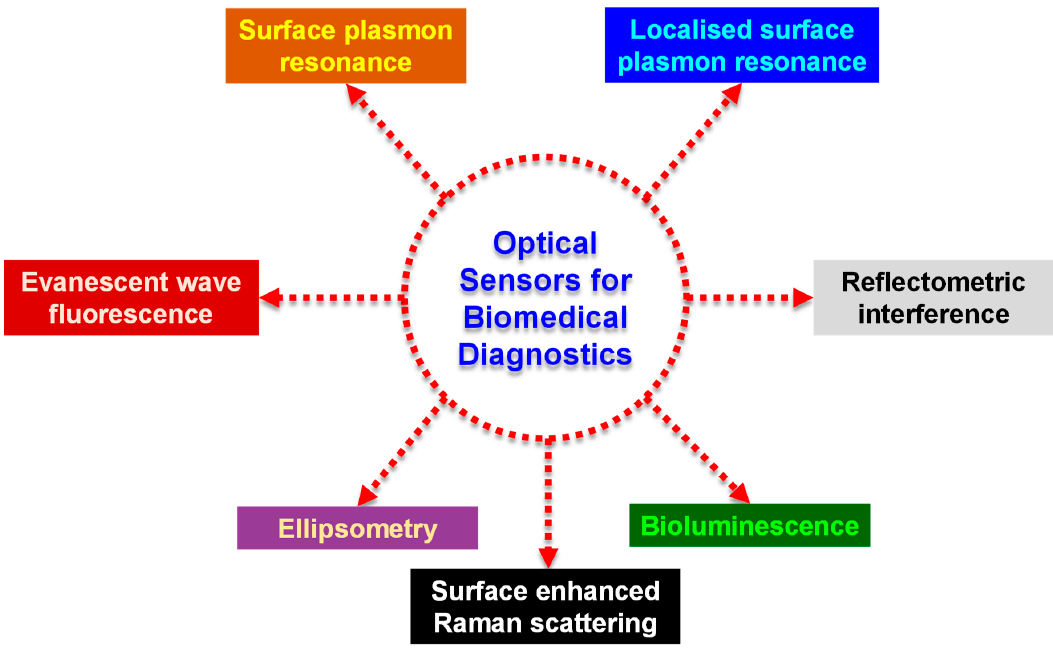
Figure 1. Different types of sensors classified on the basis of the underlying optical phenomenon arising from receptor-analyte interactions.